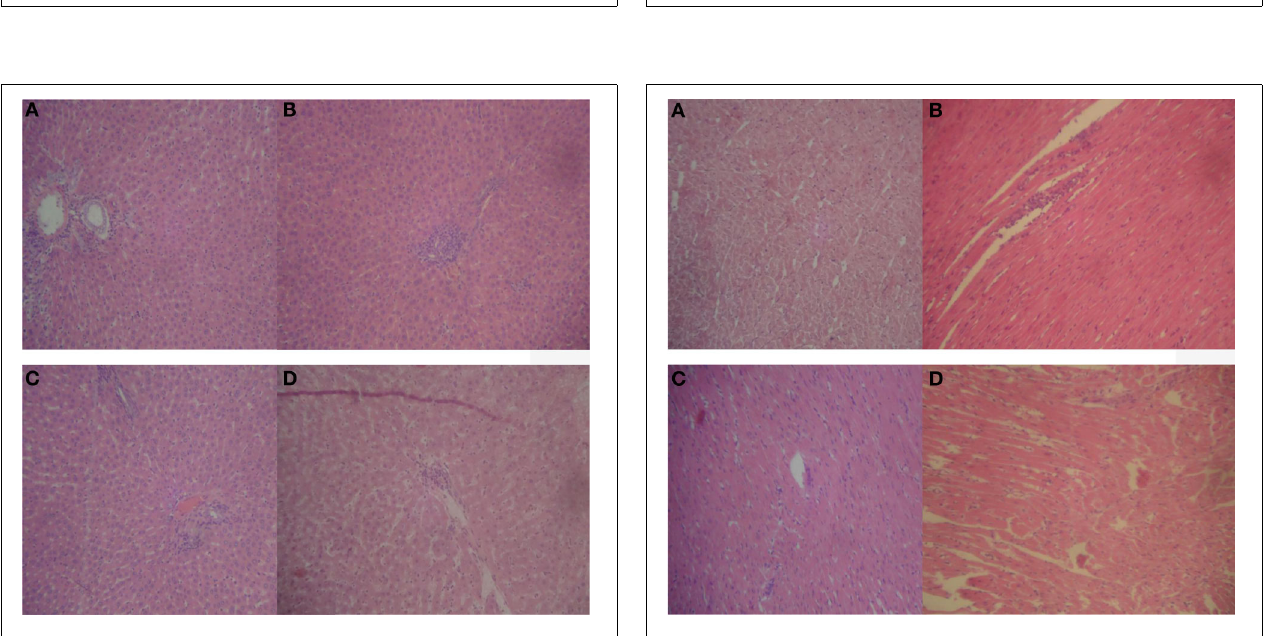
FIGURE 4 | Representative sections of rat heart in respect of 60 days treatment. (A) Normal rat heart showing normal cardiac myocytes and fascicules; (B) 20mg/kg/day HLE-FP-treated rat heart showing few lymphocytic infiltrations around the cardiac myocytes and fascicules; (C) 100mg/kg/day HLE-FP-treated rat heart showing no remarkable histological lesions; and (D) 500mg/kg/day HLE-FP-treated rat heart showing occasional lymphocytic aggregates around the cardiac myocytes ( × 100